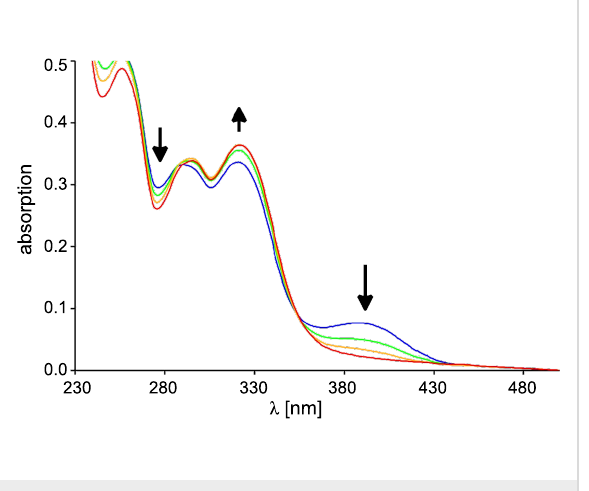
Figure 3: UV spectral change of phenolate 5 (blue) in dichloro- methane (c = 5.6 × 10 − 5 M) at 20 °C upon addition of 10 (green), 20 (yellow) and 60 equiv TFA ( 6 , red).